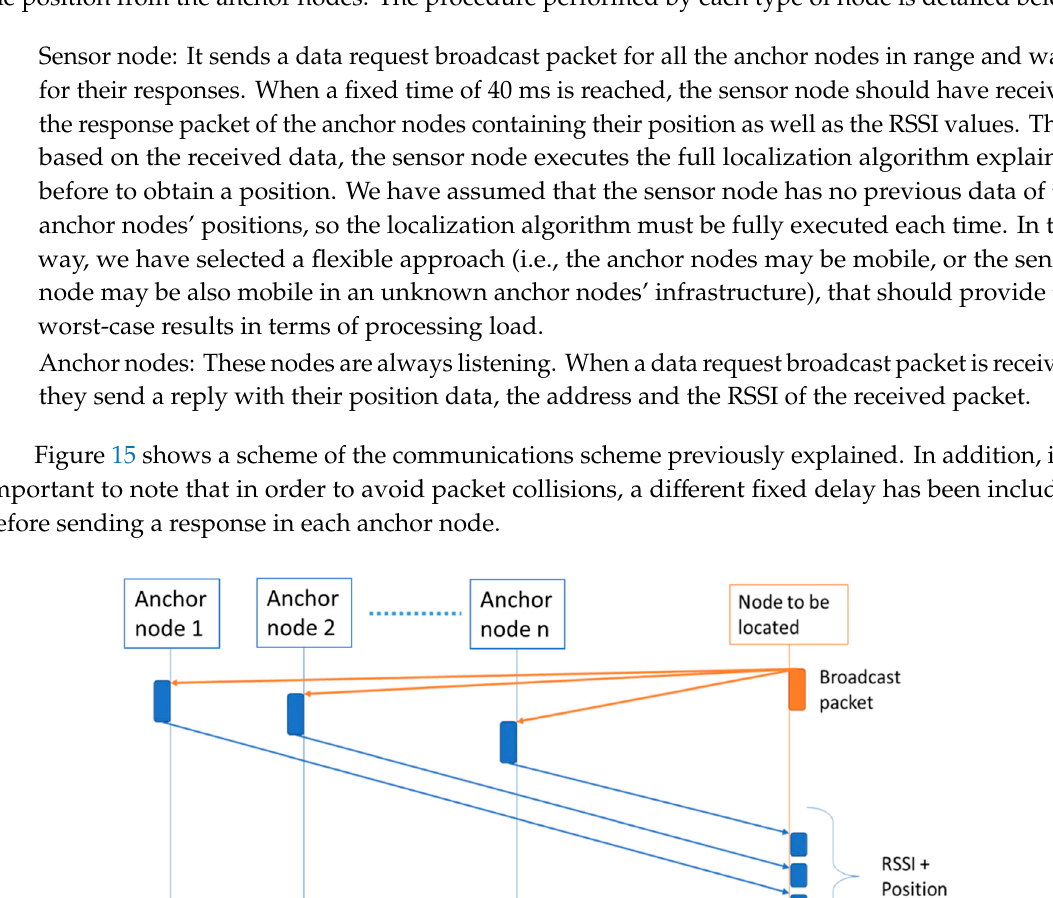
Figure 16. Experimental scenarios. These scenarios were implemented in the simulator as well as in a real outdoor set-up for further comparison. At the real setup, measurements were taken every meter on the x- axis for the three scenarios and every meter on the y- axis for scenarios 1 and 3. However, for scenario 2 measurements were taken every two meters on the y- axis. The obtained position was the average of 10 position measurements for scenario 1 and for the other two the average of 100 positions (Table 1).